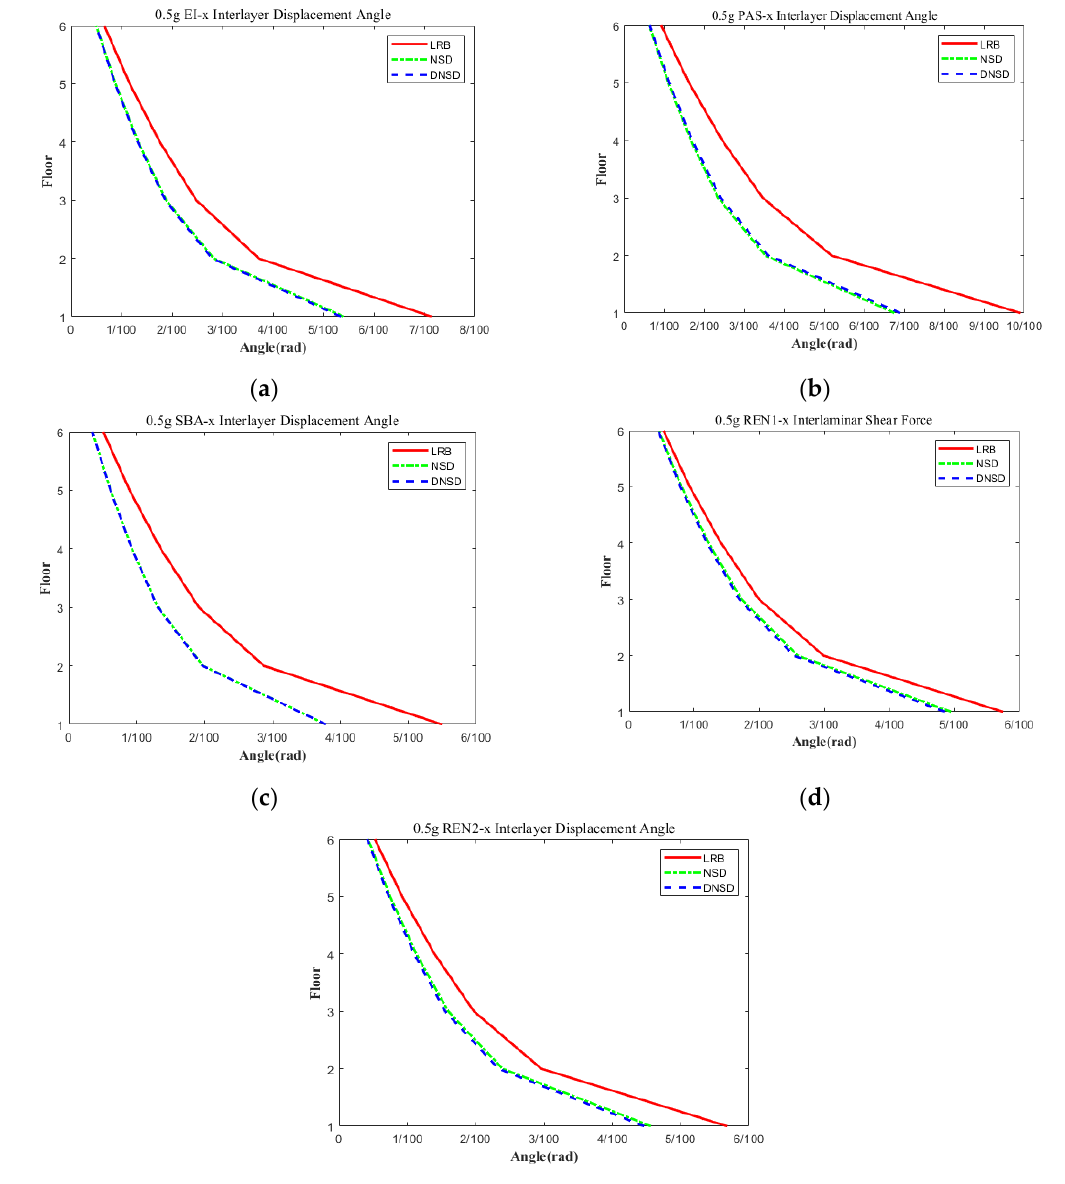
Figure 22. Comparison of inter-story displacement angles among three models under a 0.5 g peak input of different seismic waves. ( a ) Interlaminar displacement angle of 0.5 g peak value of EL wave. ( b ) Interlaminar displacement angle of 0.5 g peak value of PAS wave. ( c ) Interlaminar displacement angle of 0.5 g peak value of SBA wave. ( d ) Interlaminar displacement angle of 0.5 g peak value of REN1 wave. ( e ) Interlaminar displacement angle of 0.5 g peak value of REN2 wave.